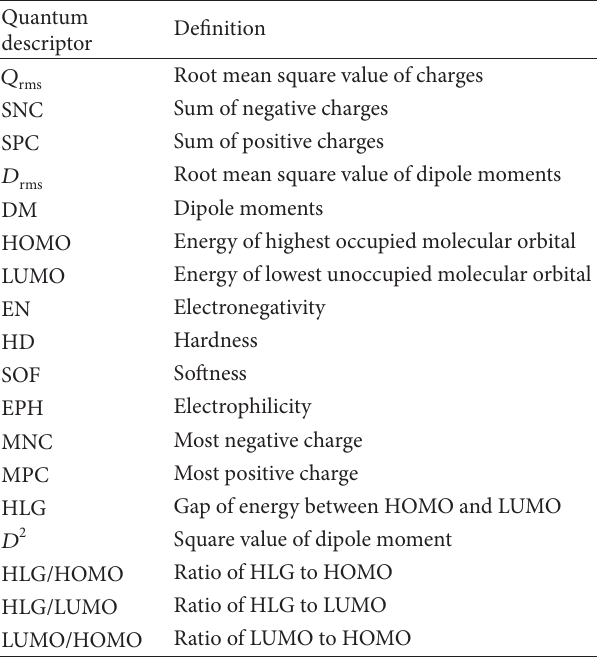
T 2: Brief description of the calculated quantum chemical descriptors used in this